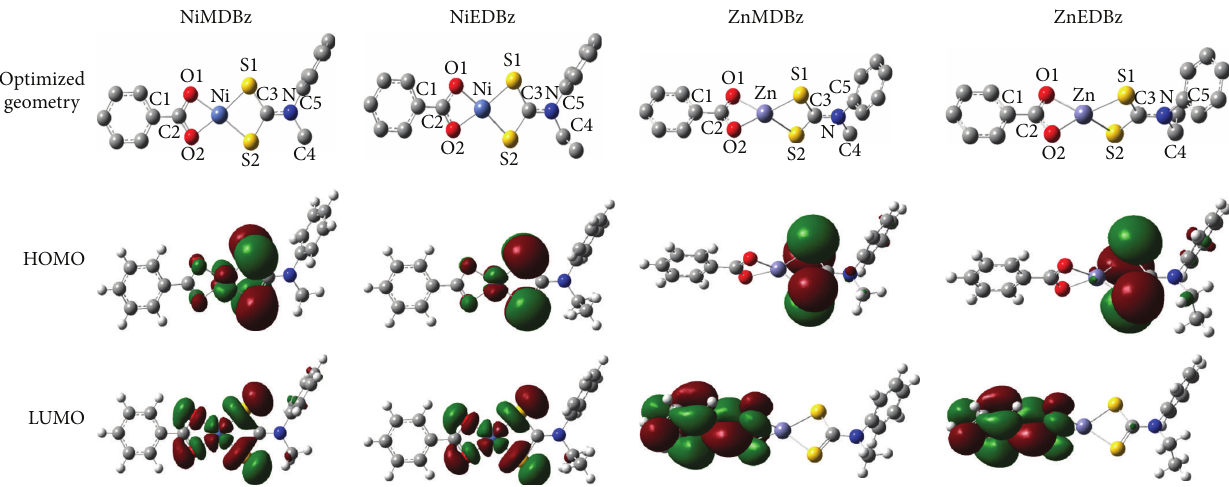
Figure 2: Optimized structures and HOMO and LUMO surfaces of NiMDBz, NiEDBz, ZnMDBz, and ZnEDBz at B3LYP/6-